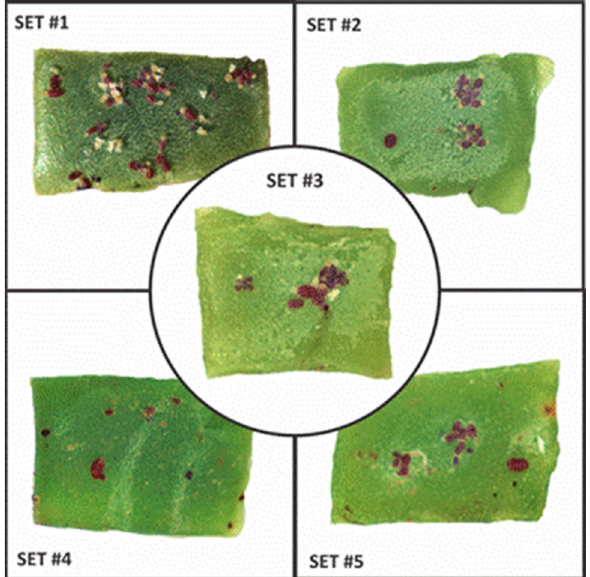
Figure 10. Picture of the five biological samples used for replication of the primary optical experiment of this research work: in-vivo measurement of the fluorescence spectrum of Dactylopius opuntiae in fresh cladode